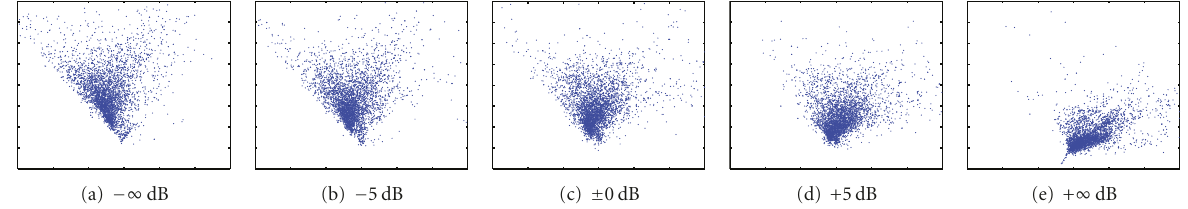
Figure 2: Distributions of the first and second principal components of extracted features from the no. 1 piece of the RWC Music Database: Popular Music. Five figures show the shift of feature distribution by changing the volume of the drum part. The shift of feature distribution causes the genre classification shift.